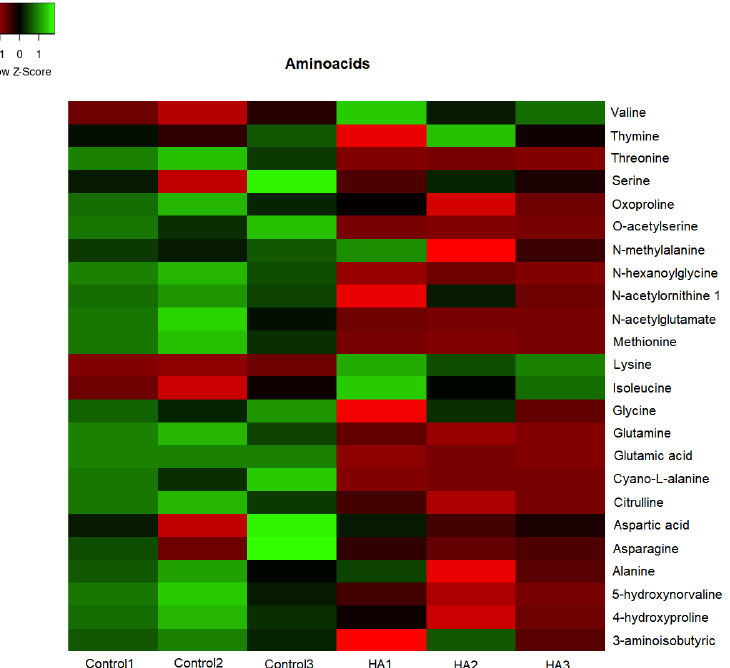
Figure 6. The concentration map of amino acids (heat map of scaled concentrations) by plants treated with humic acids (HA) or not (Control).